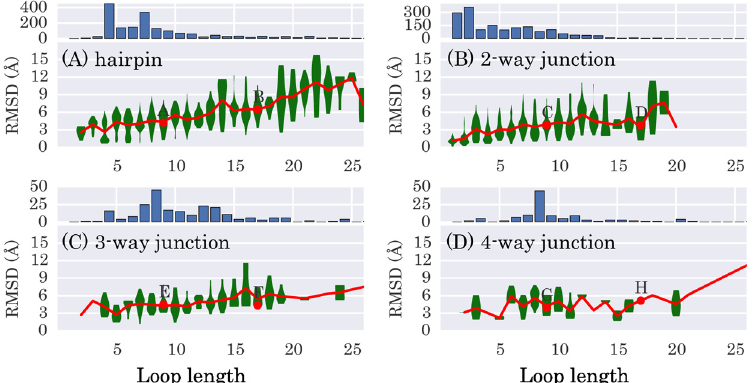
Fig 7. Violin plot of the RMSDs as a function of loop length for four types of loops in the dataset RNA 3D Hub. The red lines denote the mean RMSDs between predicted structures and experimental structures. The green body of each violin represents a kernel density estimation of the RMSD distribution. The histogram on the top of each figure gives the loop length distribution in the dataset. Figures (A), (B), (C), and (D) correspond to 1768 hairpin loops, 1649 internal loops, 230 three-way and 113 four-way junction loops, respectively. RMSDs are calculated based on heavy atoms after optimal superposition of the predicted structures with the experimental ones. The loops exemplified in Fig 8 are drawn as red dots and labeled from A to